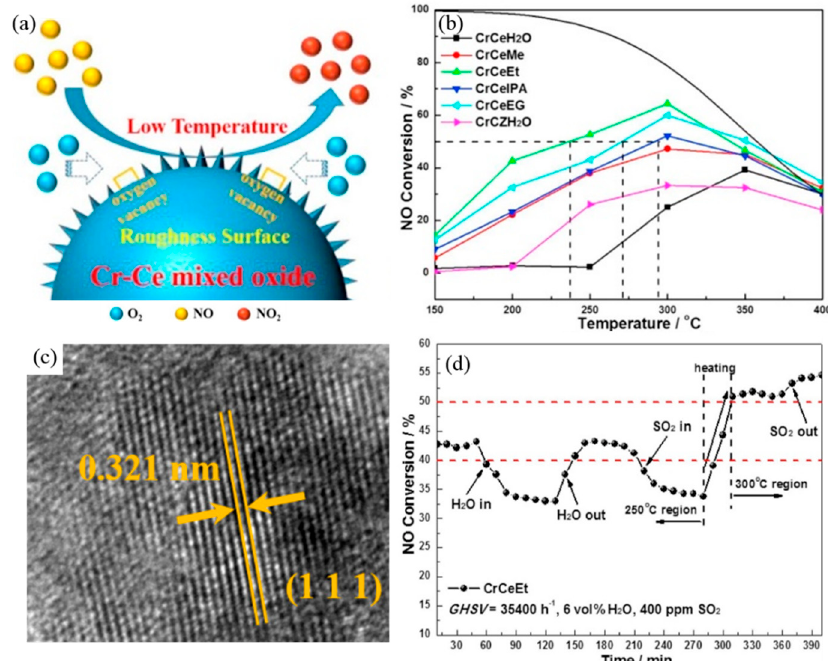
Figure 5. ( a ) Surface oxidation mechanism of 3D spherical Cr–Ce mixed oxides, ( b ) NO conversion of hydrothermal synthesis catalysts with different solvents, ( c ) HRTEM image of Cr–Ce/Et catalysts, and ( d ) sulfur and water resistance at 250–300 °C [108]. Reproduced from Ref. [108], Copyright 2018, Elsevier.